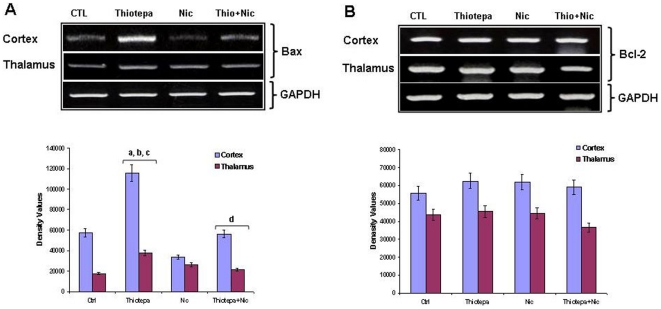
Co-treatment effect of nicotinamide (Nic) on thiotepa-induced Bax and Bcl-2 mRNA levels.Representative RT-PCR analysis shows expression levels of (A) Bax and (B) Bcl-2 mRNA in the cortex and thalamus of 7-day-old rat pups. Treatment with thiotepa (30 mg/kg for 4 h) increased Bax mRNA levels in the cortex and thalamus. Treatment with (1 mg/g) of nicotinamide for 4 h significantly reduced thiotepa-induced up-regulation of Bax mRNA levels in the cortex and thalamus, as shown. Detailed procedures are described in the Materials and Methods section. The mRNA bands of RT-PCR were quantified using Sigma gel software; these differences are represented in the graph. GAPDH was used as mRNA loading control. Density values are expressed as mean ± SEM (n = 5 animals/group). The density values on the Y-axis are expressed as arbitrary units (AU). Statistical difference was determined using one-way analysis of variance (ANOVA) followed by Student's t-test. (aSignificantly different from CTL, [cortex P<0.01 and thalamus P<0.01]; bSignificantly different from Nicotinamide, [cortex P<0.001 and thalamus P<0.05]; cSignificantly different from Thiotepa + Nicotinamide, [cortex P<0.01 and thalamus P<0.05]; dSignificantly different from Thiotepa, [cortex P<0.01 and thalamus P<0.05]).